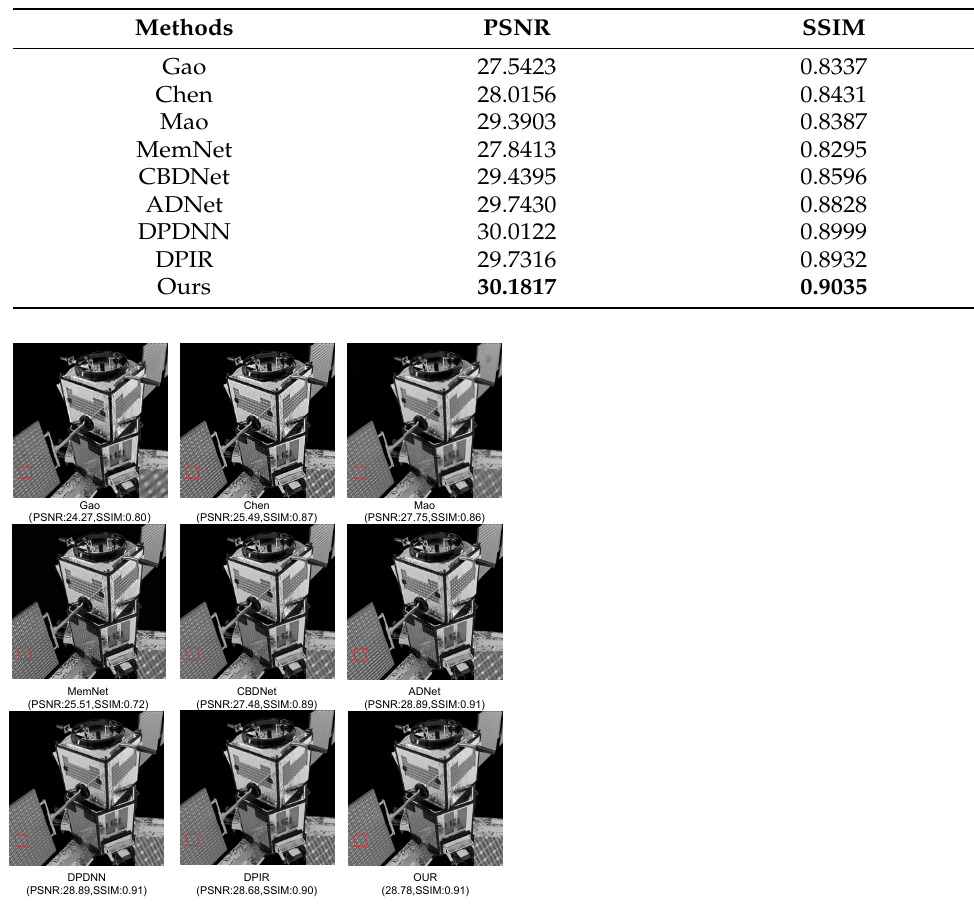
Figure 11. Restoration using different state-of-the-art methods on mild turbulence blur (The red boxes represent the focus